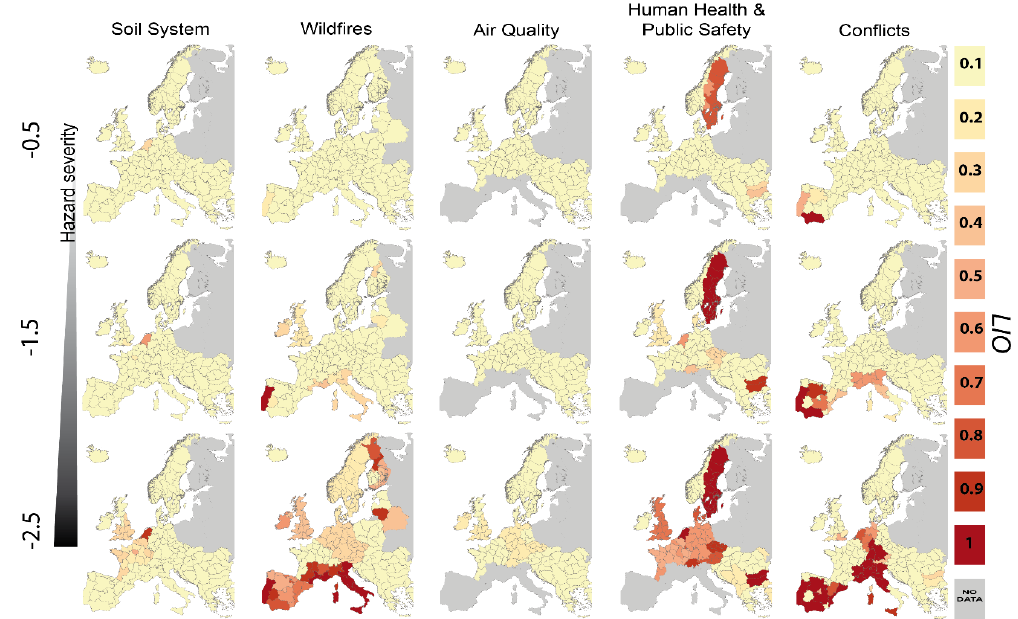
Figure 6. Drought risk maps with the likelihood of impact occurrence (LIO) in the impact categories Soil System, Wildfires, Air Quality, Human Health and Public Safety, and Conflicts; (columns) for three hazard levels of SPEI with − 0.5: near normal, − 1.5: severely dry, and − 2.5: extremely dry